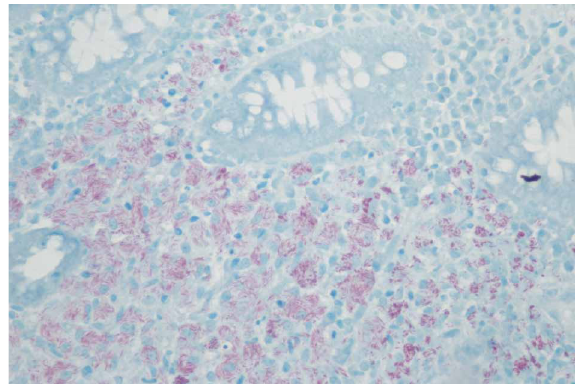
Figure 3: Rectal biopsy: acid fast staining showing sheets of macrophages packed with bundles of acid-fast bacilli, characteristic of Mycobacterium avium intracellulare . (Acid fast stain, magnification